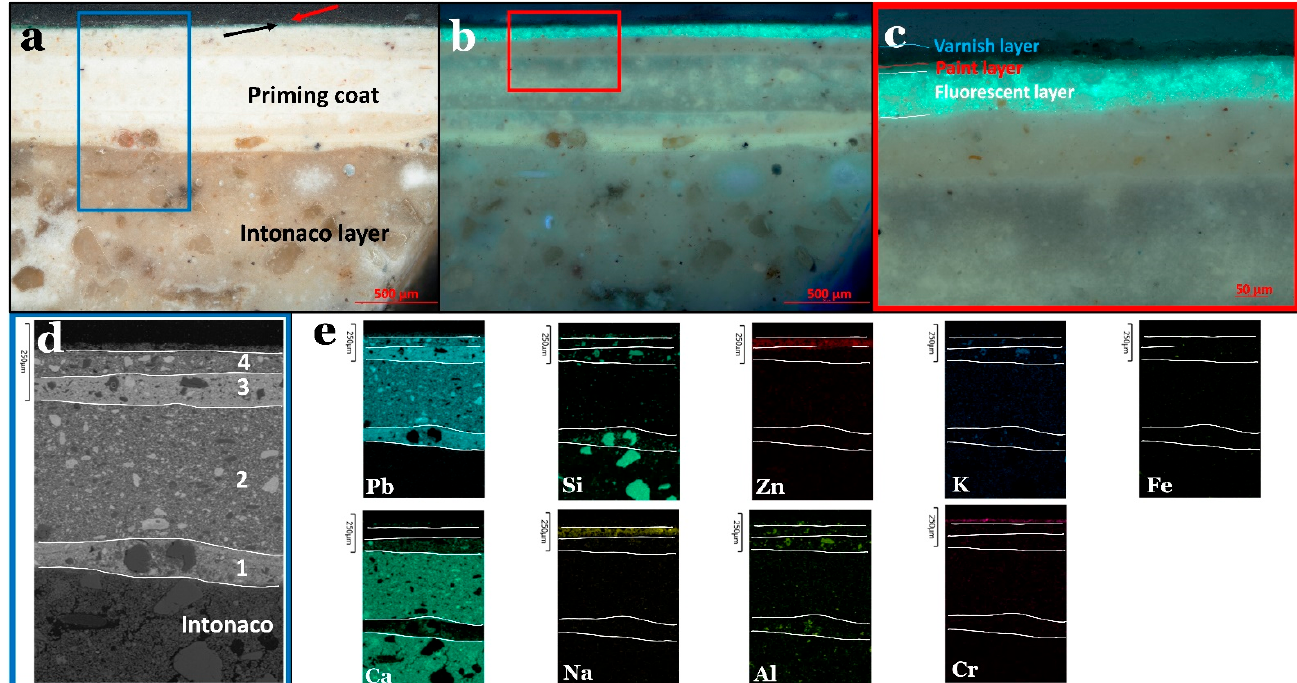
Figure 2. ( a ) An optical microscopy image showing the intonaco, priming, paint layer (black arrow), and varnish layer (red arrow). ( b ) The same view under UV light. ( c ) A magnified field of the red rectangular present in ‘b’. The image illustrates the fluorescent layer belonging to the priming coat in addition to the paint and the varnish layers. ( d ) A backscattered SEM image (of the area in the blue rectangle indicated in ‘a’) revealing the intonaco layer and the superimposed four layers of the priming coat. ( e ) Elemental maps acquired by SEM–EDX of the same field are presented in ‘d’.